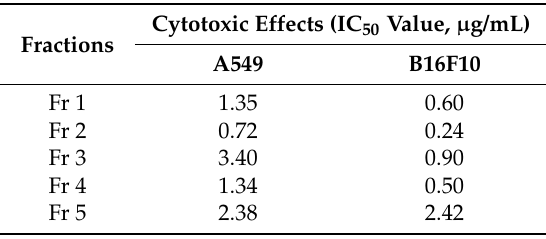
Table 2. Cytotoxic effects of different fractions of H. atra crude saponin.